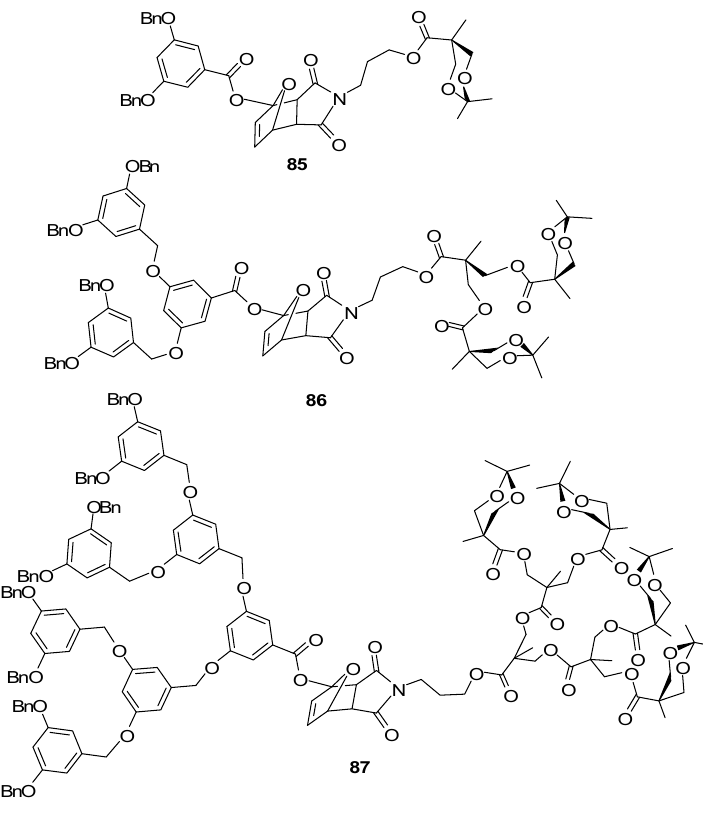
Figure 6. Unsymmetrical dendrimers